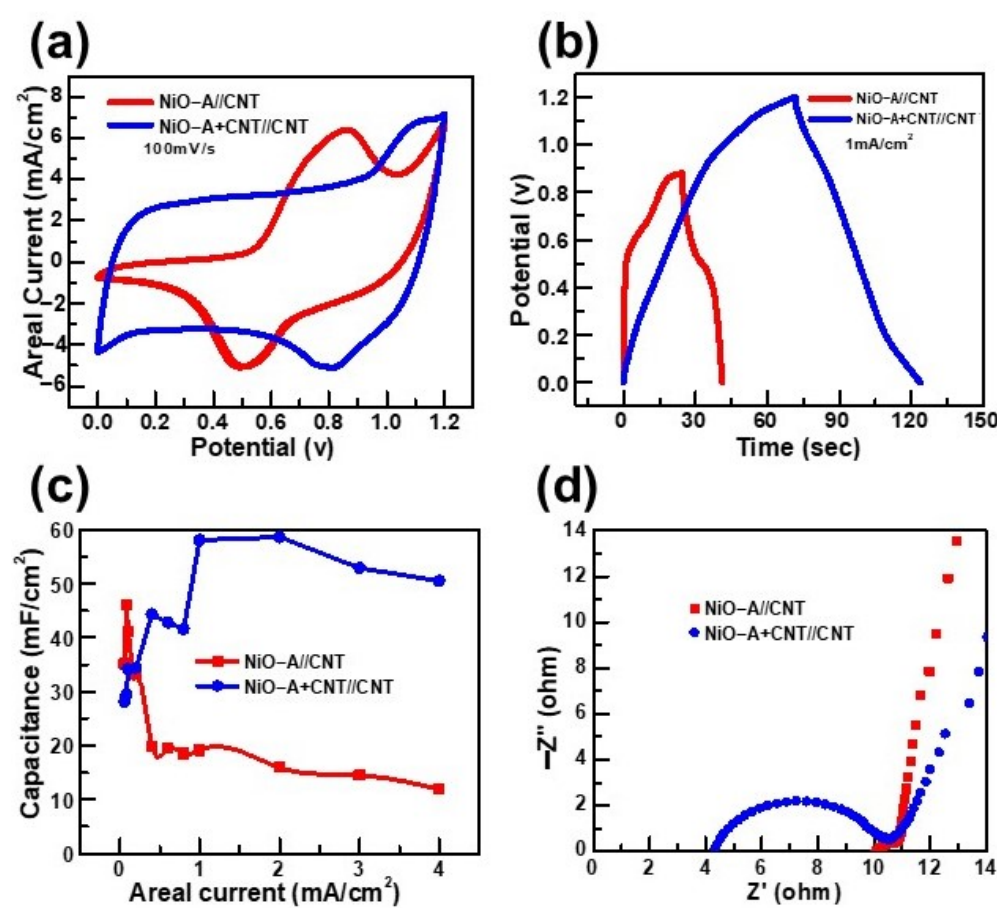
Figure 6. Comparison of electrochemical storage performance of NiO-A//CNT and NiO- A+CNT//CNT as two full-cells: ( a ) CV curves; ( b ) CD curves; ( c ) Areal capacitance functions; ( d ) Nyquist plot of EIS.